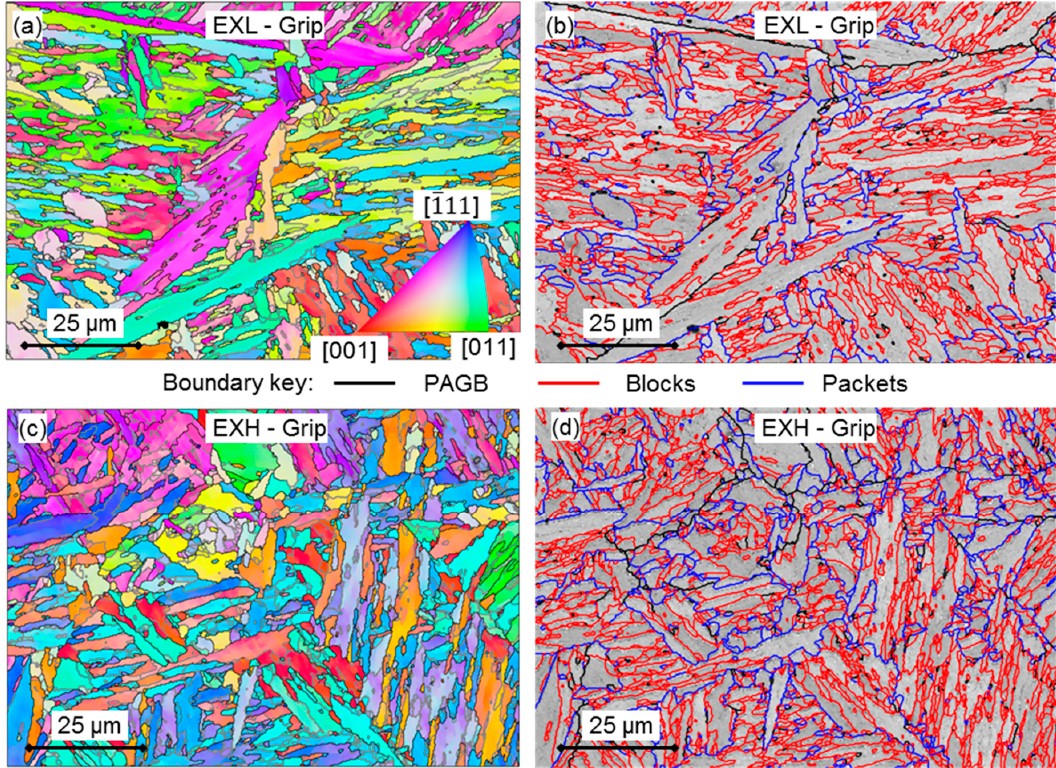
Figure 8. Inverse Pole Figures (IPF) maps of the tested ( a ) EXL and ( c ) EXH grip regions where the colouring identifies the crystallographic directions parallel to the sample normal ( z direction) according to the colour key given in ( a ). Boundaries of >1.5° misorientaitons are outlined. These maps are used to reconstruct block (red), packet (blue), and PAGB (thick black) boundaries in ( b , d ), respectively.